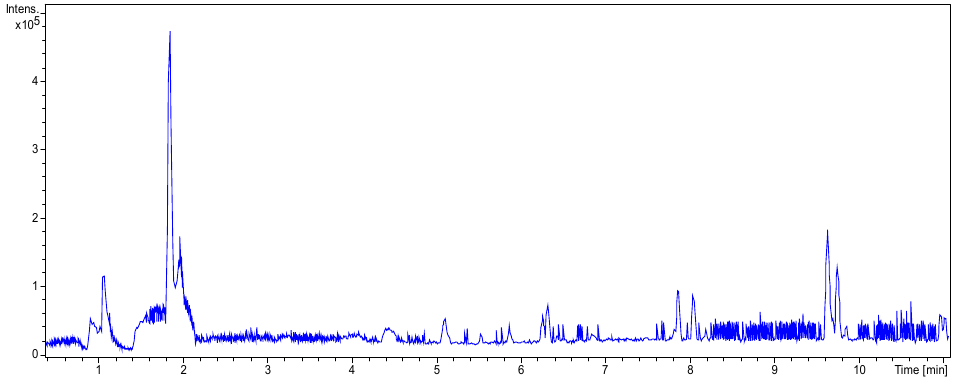
Figure 7. LC HRMS Chromatogram: melanin produced by Pseudomonas putida ESACB 191 in positive mode.